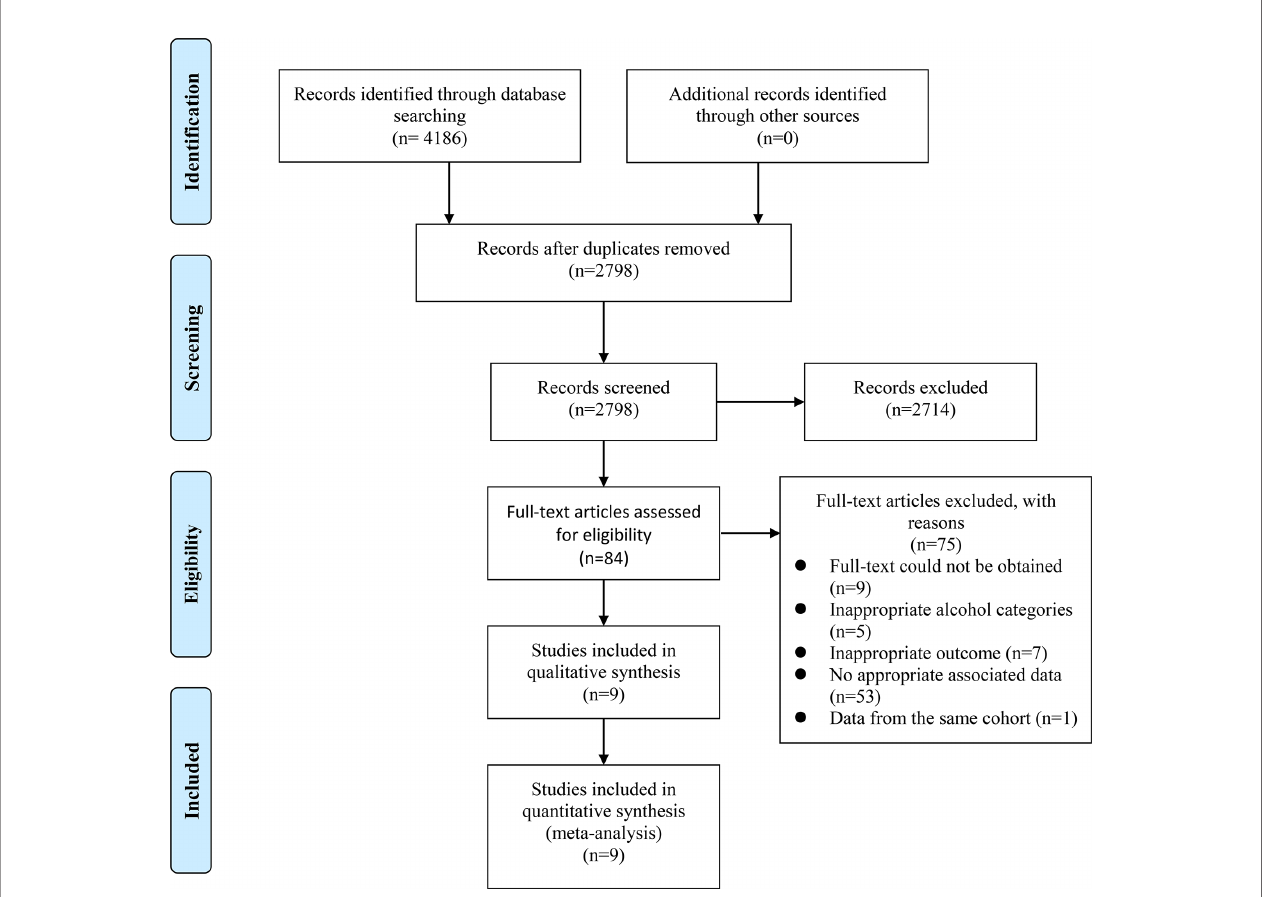
FIGURE 1 | Flow diagram of the literature search and study selection